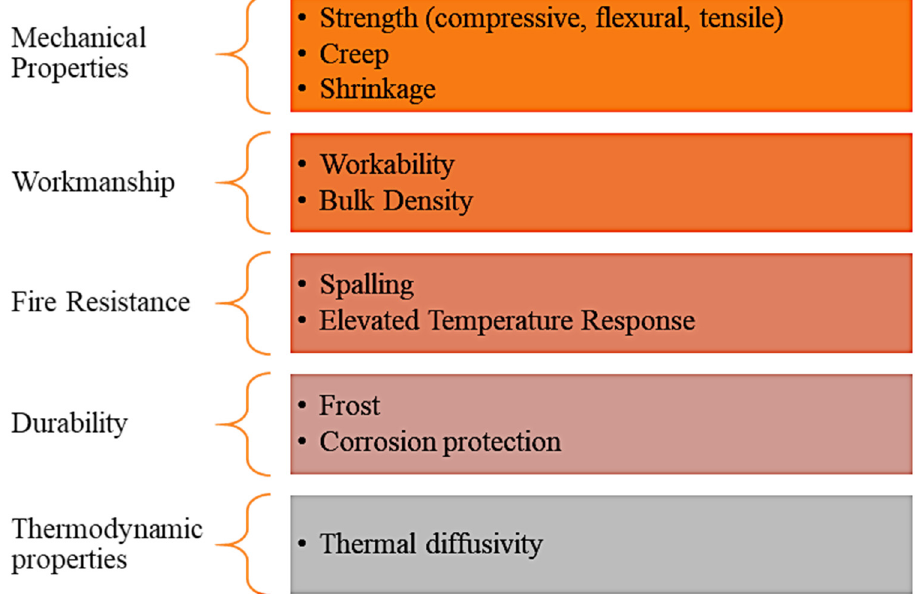
Figure 1. Properties of concrete.